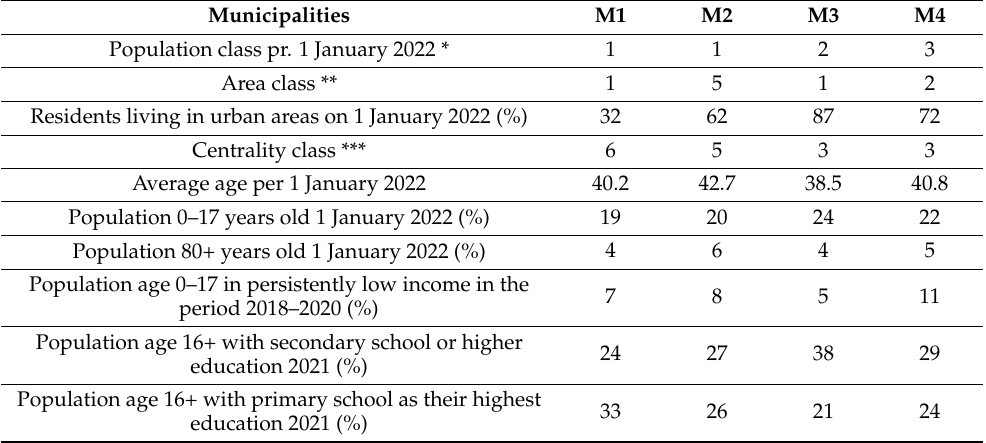
Table 1. Characteristics of the four municipalities from which the included documents are